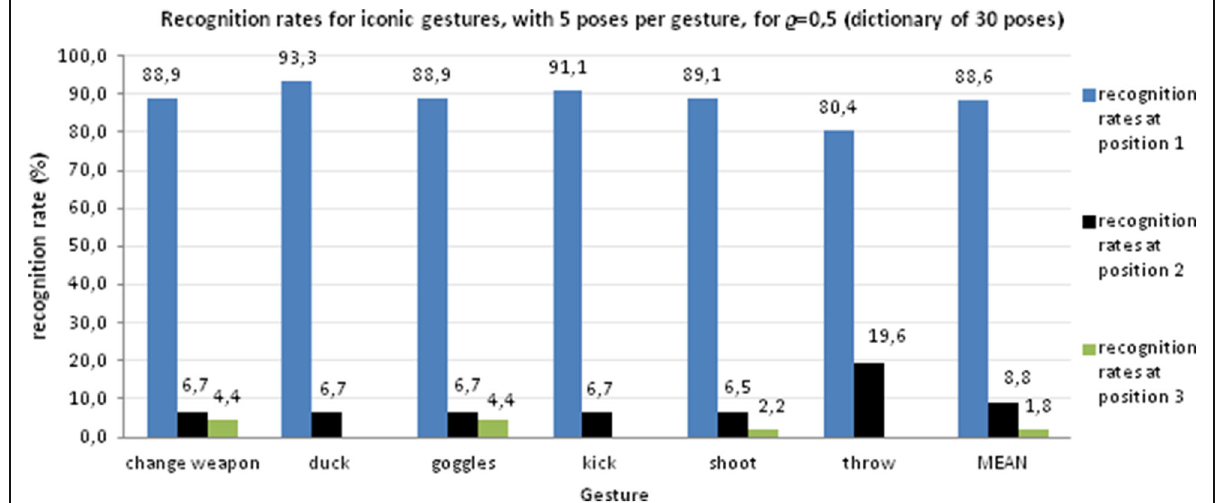
Fig. 7 Recognition rates for iconic gestures of MSRC-12